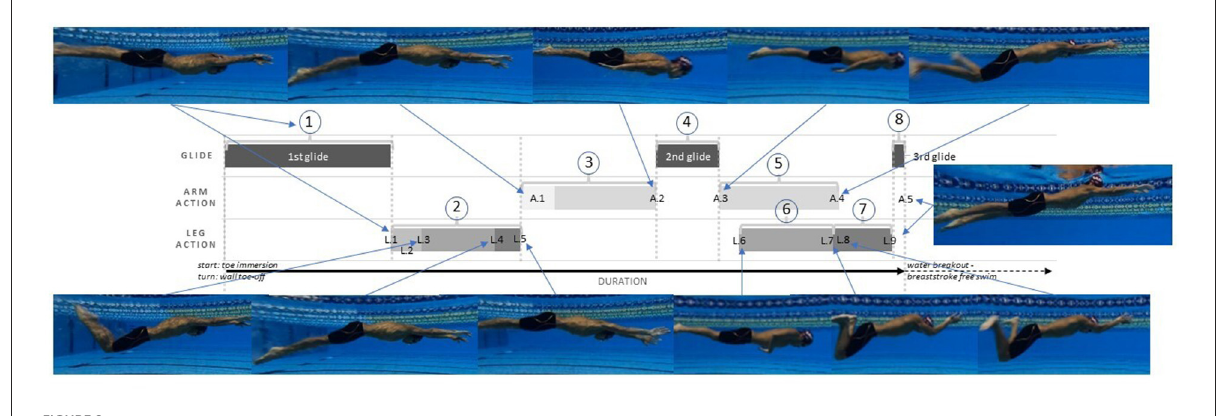
FIGURE2 A phase duration sequence of the Fly-Kick First Technique. Refer to Figures 1A,B for number and letter annotation information.